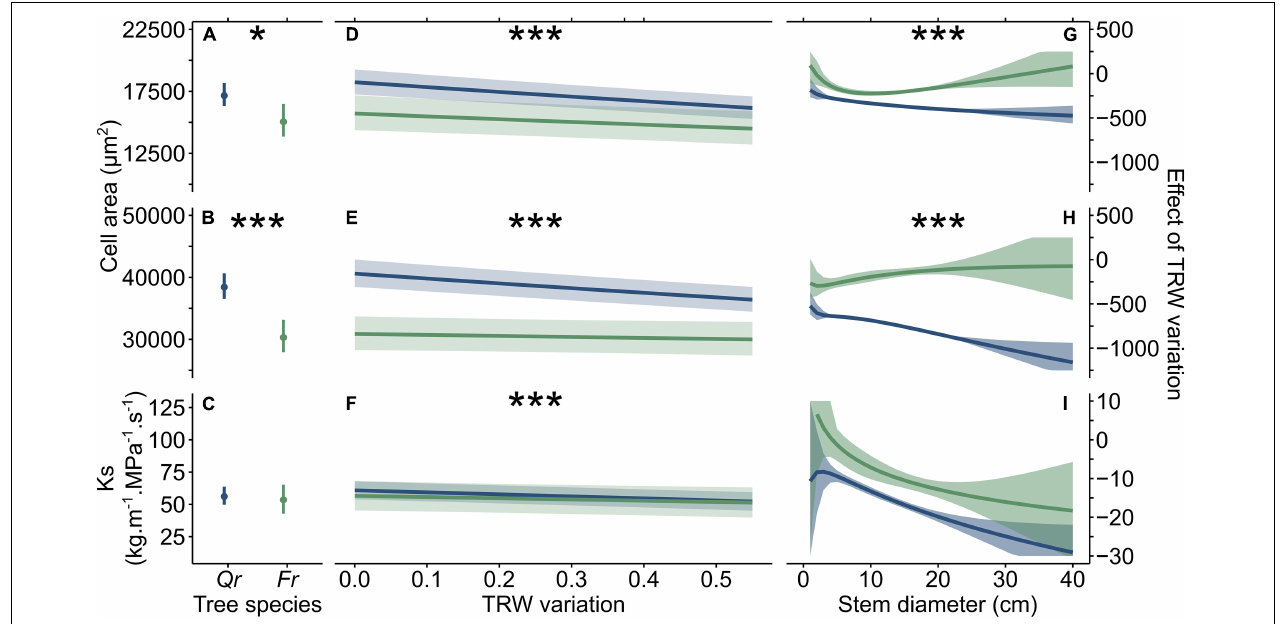
FIGURE 3 | The modeled mean values of mean vessel lumen area (VLA mean ), 90th percentile of VLA (VLA 90 ), and specific hydraulic conductivity (Ks) ( A–C , respectively) and the effect of TRW variation on VLA mean , VLA 90 , and Ks of fitted models: ( D–F , respectively), and changes in the slope of the linear regression of TRW variation with increasing stem diameter in relation with VLA mean , VLA 90 , and Ks ( G–I , respectively). Blue color represents Quercus and green color represents Fraxinus . Statistical significance of differences in the trends between species is expressed by asterisks (* is p < 0.05 and *** is p < 0.001).